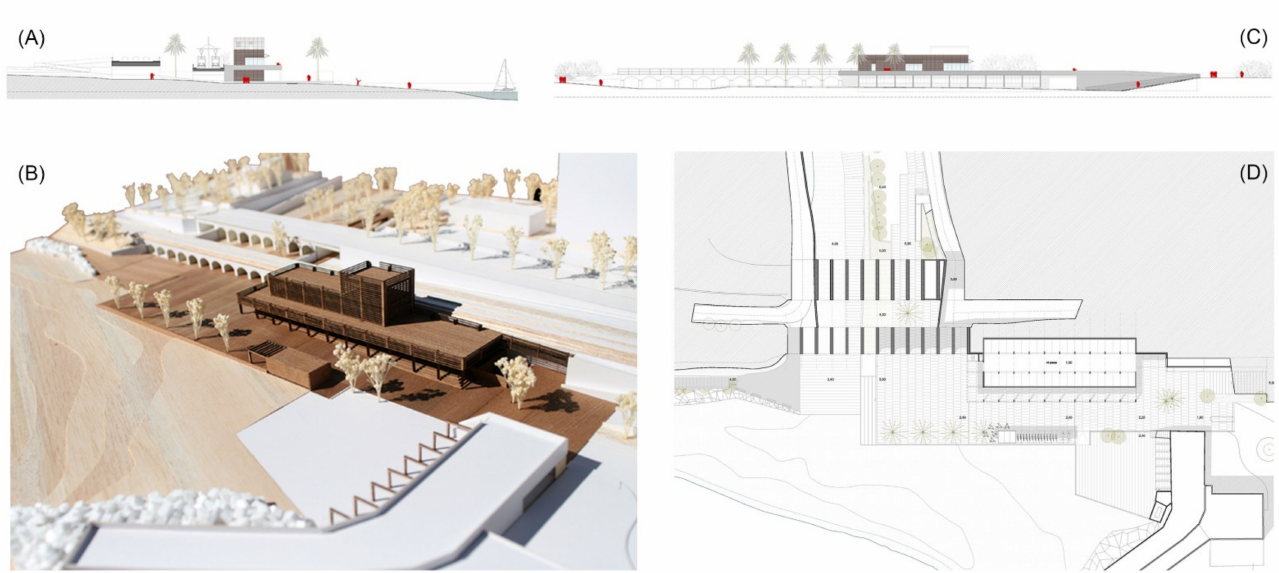
Figure 12. Urban and architectural project for the case study of the stream mouth in Llavaneres (Source: authors’ own). ( A ) Transversal section of the underground passages. ( B ) Model picture of prefabricated constructions. ( C ) General el- evation of the maritime façade. ( D ) General floorplan with green treatment of the stream, floodable squares and light-weight constructions for local services and the railway